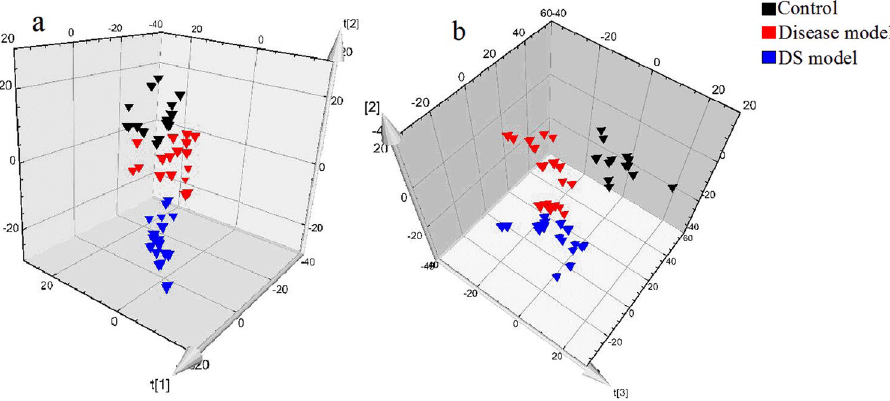
Figure 4. PCA 3D Score plots of the serum profiles in positive ion mode ( a ) and negative ion mode ( b